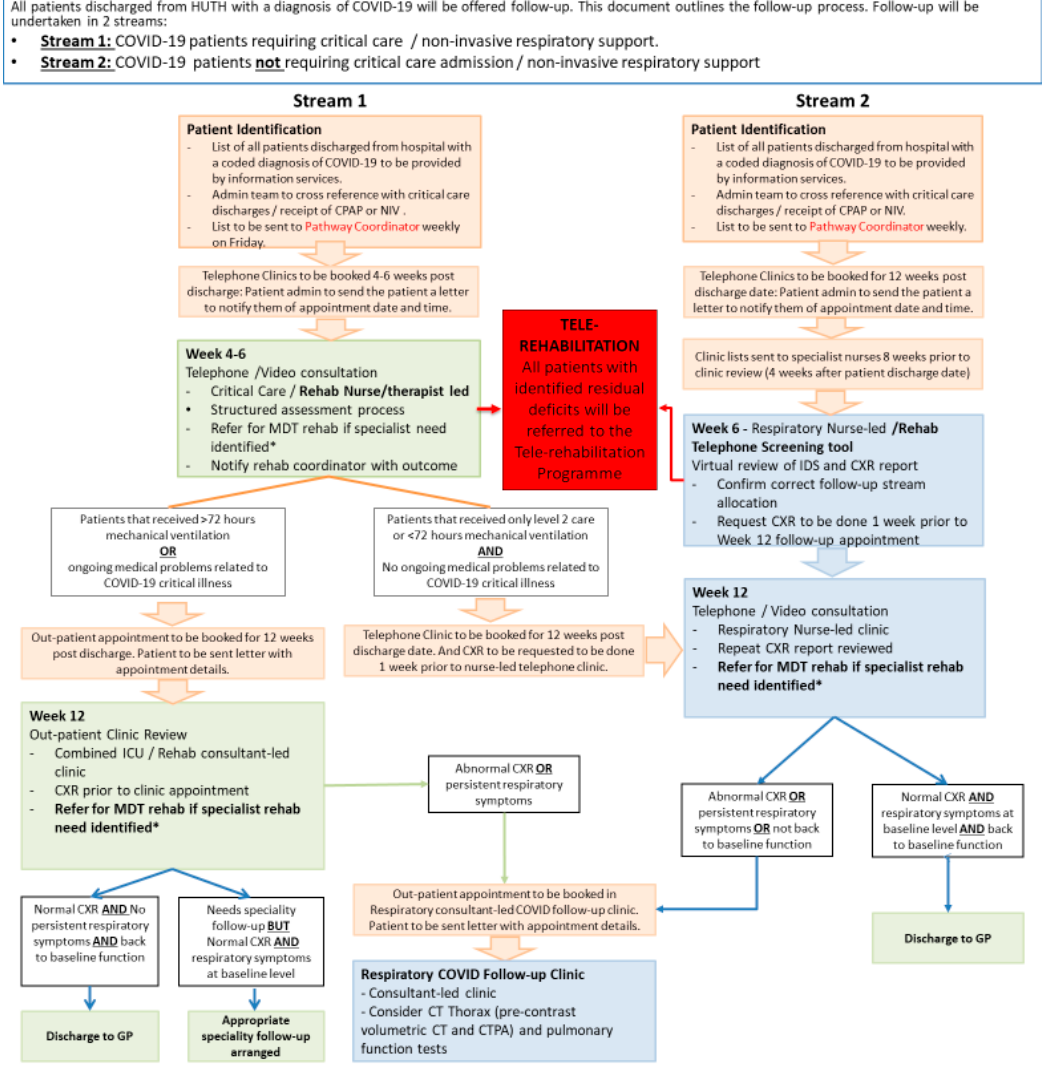
Figure 1. Proposed post-COVID-19 follow-up pathways. CPAP: continuous positive airway pressure; NIV: non-invasive ventilation; MDT: multi-disciplinary team; CXR: chest X-ray; ICU: intensive care unit; CT: computerized tomography; CTPA: computerized tomography pulmonary angiogram; and HUTH: Hull University teaching hospitals. * Specialist rehabilitation needs include but not limited to cognitive impairment, speech and swallowing difficulties, severe mobility and balance issues, and severe mood (anxiety and depression) issues.